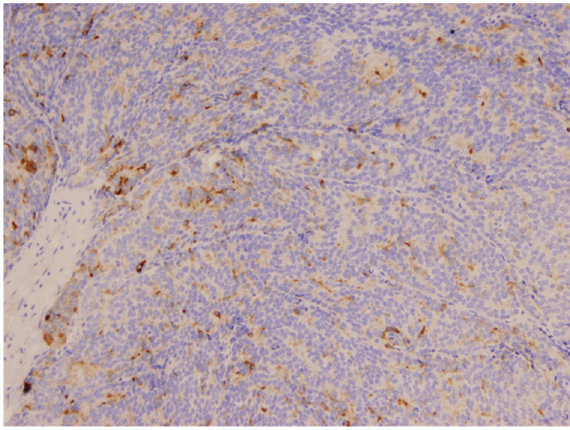
Figure 4: The cells showed focal and irregular positive staining for prostate specific antigen